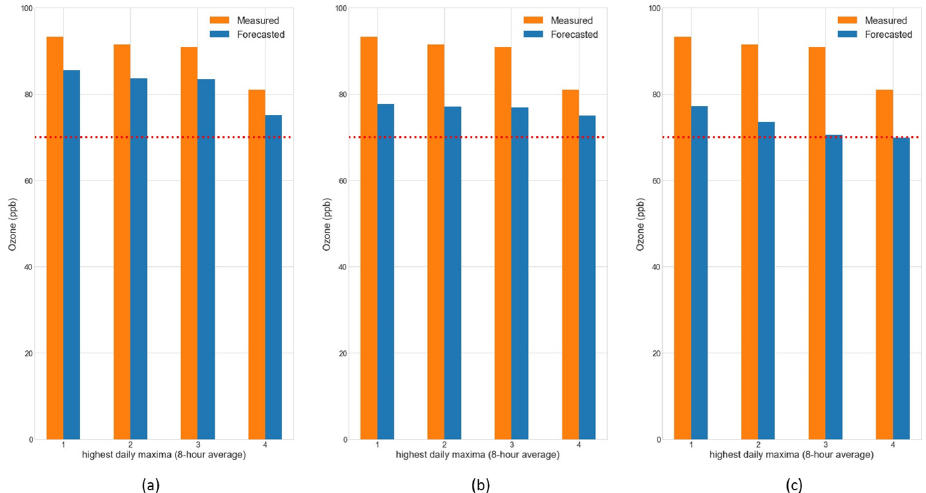
Figure 16. Determination of nonattainment status for reference station for 1 h ( a ), 3 h ( b ) and 6 h ( c ) forecasting horizons. forecasting